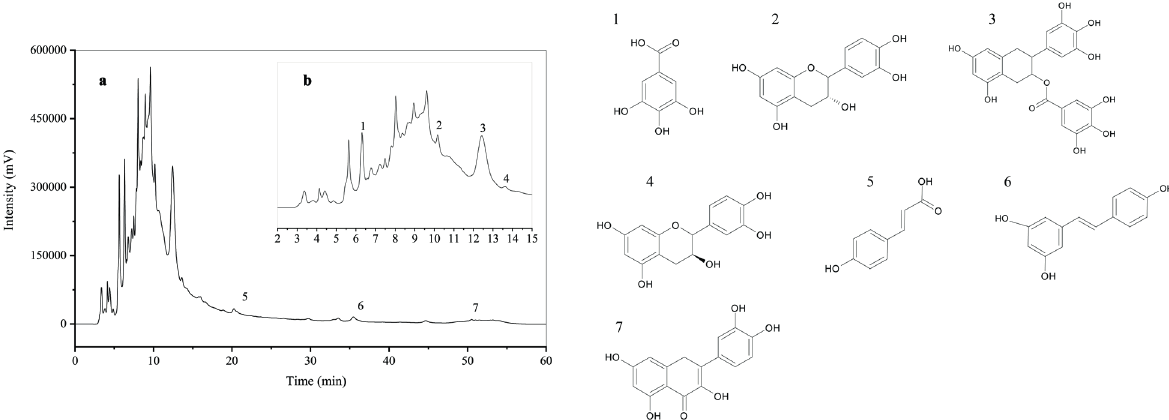
Figure 1 - ( a ) Chromatogram of jabuticaba skin flour aqueous extract, with peak identification: 1. gallic acid (time = 6.311 min); 2. catechin (time = 10.127 min); 3. epigallocatechin gallate (time = 12.418 min); 4. epicatechin (time = 13.602 min); 5. p -coumaric acid (time = 20.238 min); 6. resveratrol (time = 35.462 min) and 7. quercetin (time = 51.780 min). ( b ) expansion of the chromatogram at times from 2 to 15